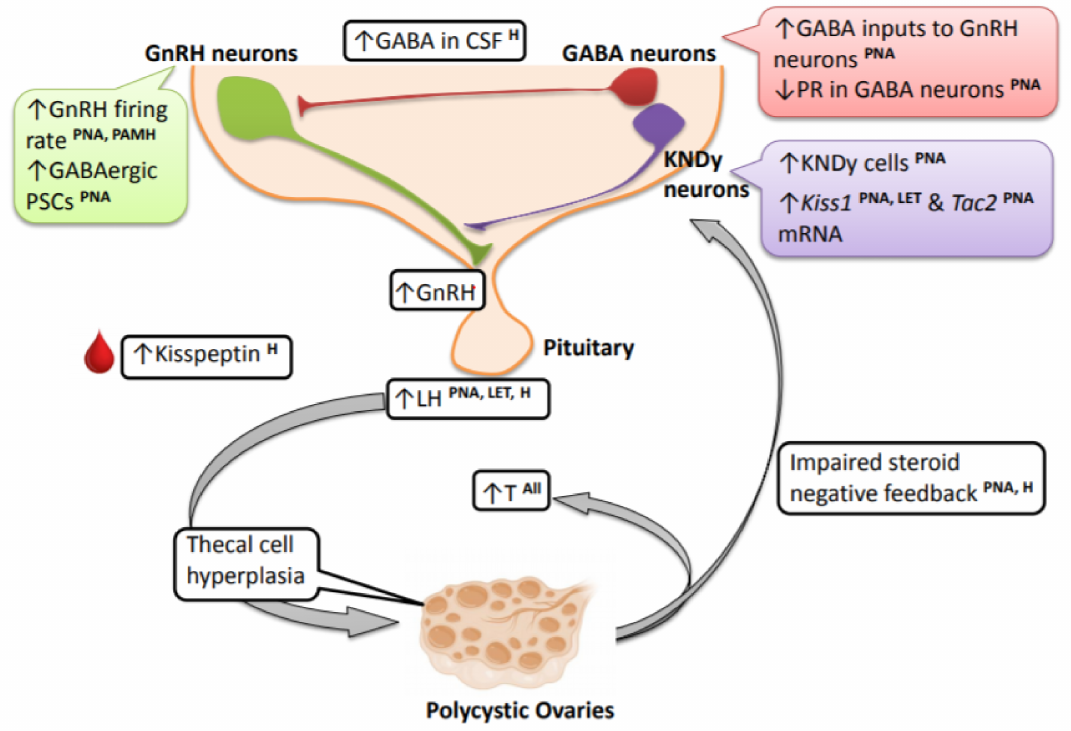
Figure 1. Changes in the brain and neuroendocrine reproductive axis in PCOS women and PCOS-like animal models. Clinical studies demonstrate very high circulating LH levels in PCOS individuals, and this is recapitulated in the prenatally androgenized (PNA) and letrozole (LET) preclinical animal models. These high-frequency LH pulses contribute to thecal cell hyperplasia and stimulate increased production and secretion of ovarian androgens, contributing to hyperandrogenemia. The elevated LH levels and LH pulse frequency seen in PCOS and the PCOS animal models point to an upstream hyperactive GnRH neural circuit. In PNA mice and mice prenatally treated with AMH (PAMH), there is an increased firing rate of GnRH neurons. PNA mice also exhibit an increase in upstream GABAergic postsynaptic currents (PSCs). There is also impaired sex steroid negative feedback observed in PNA models and PCOS women, and this may be mediated by alterations in a ff erent hypothalamic GABA neurons, at least in PNA mice. In relation to this, progesterone receptor (PR) expression is decreased in ARN GABA neurons in PNA mice and in the mediobasal hypothalamus of LET mice. Alongside GABA, there is also an increase in ARN KNDy cells and ARN Kiss1 and Tac2 mRNA levels in PNA and LET PCOS models, possibly providing an increase in excitatory signals to GnRH neurons. Refer to the article text for discussion on species di ff erences and specific brain parameters that have not